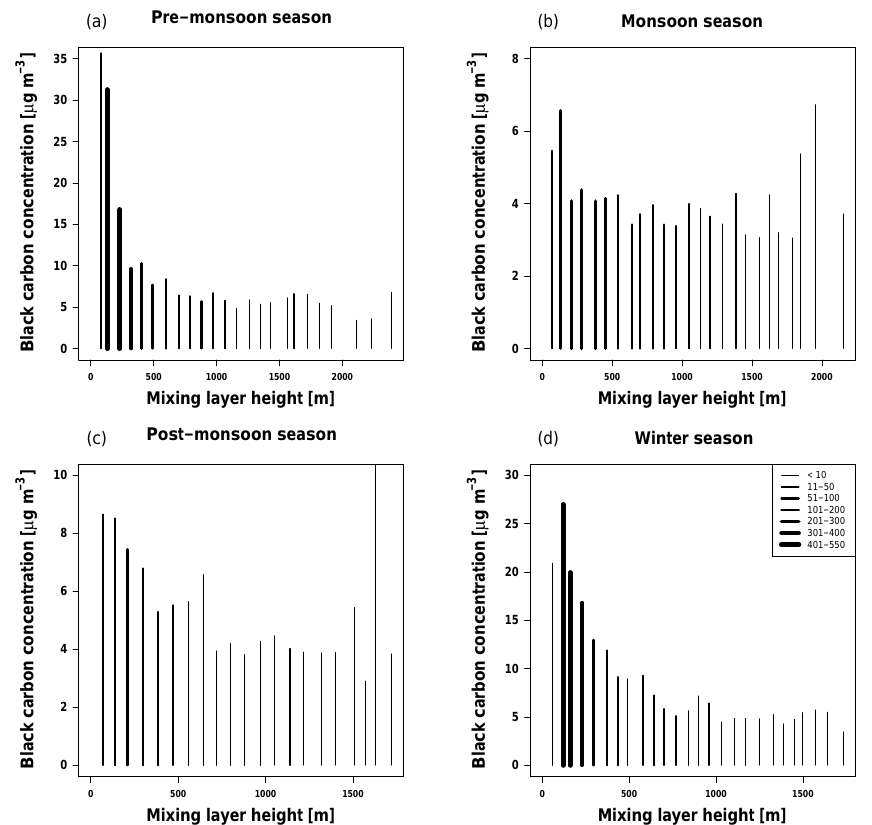
Figure 8. Dependency of the BC concentration on the MLH for (a) the pre-monsoon (March–May 2013), (b) the monsoon (June–September 2013), (c) the post-monsoon (October–November 2013) and (d) the winter (December 2013–February 2014) season. The concentration refers to a (a) 92m, (b) 82m, (c) 85m, and (d) 74m interval of the MLH (see explanation in Sect. 3.3). The widths of the bars indicate the number of data points, as given in the legend in (d)